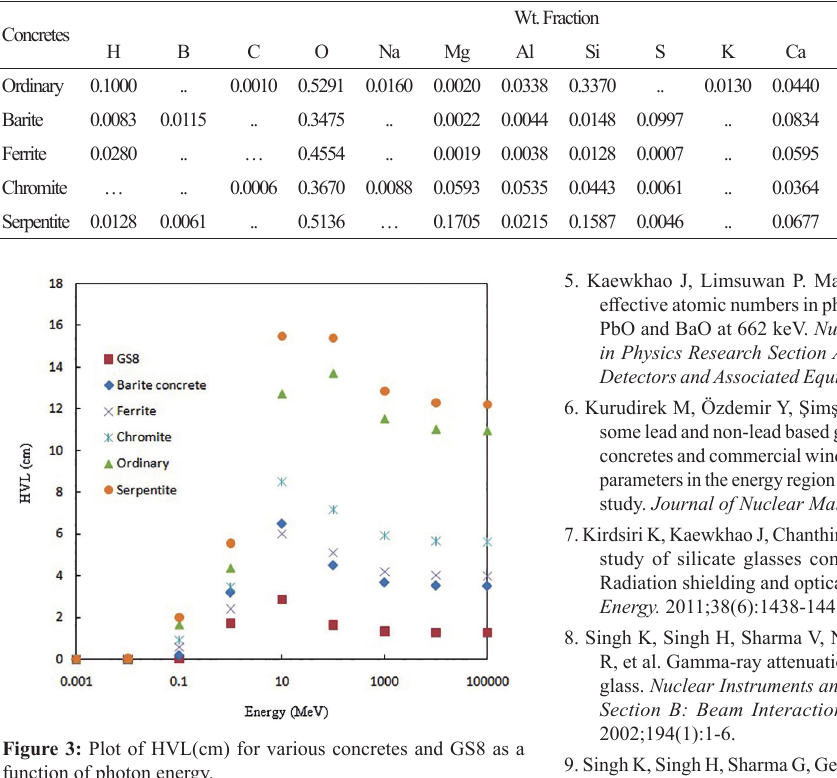
Figure 3: Plot of HVL(cm) for various concretes and GS8 as a function of photon